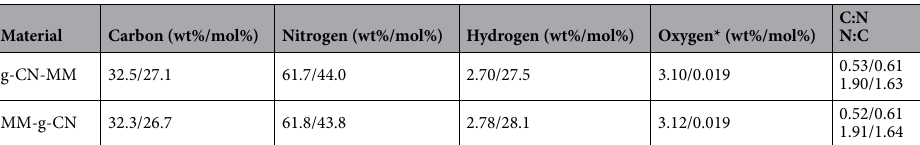
Table 1. Elemental analysis of C, N, H contents of g-CN-MM and MM-g-CN samples. *The amount of oxygen was calculated to 100%.